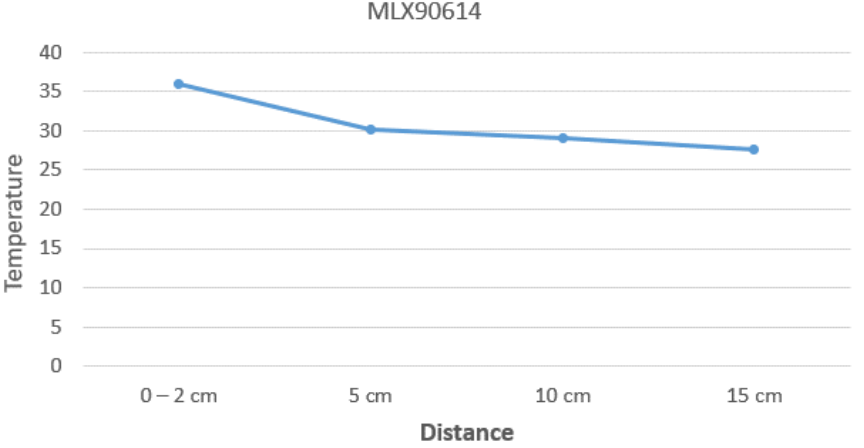
Figure 4. The effect of distance on temperature measurement.